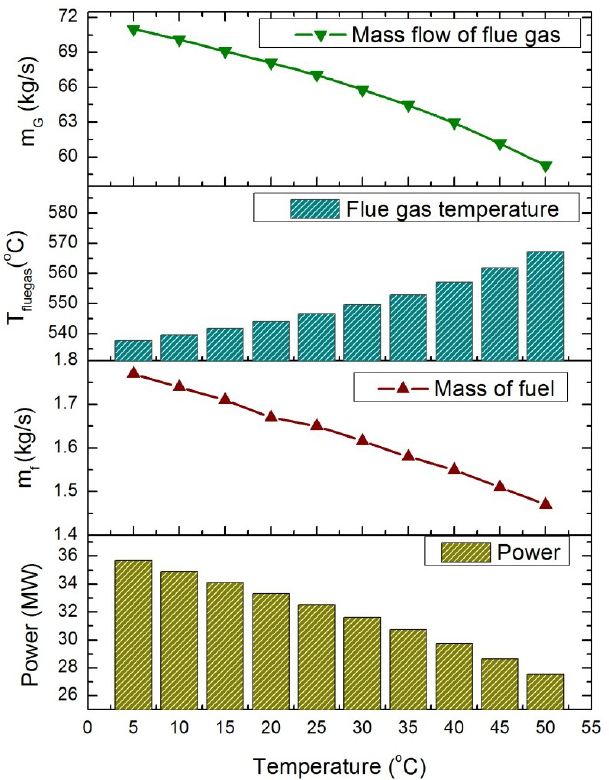
Figure 5. Performance of gas power cycle for varying inlet